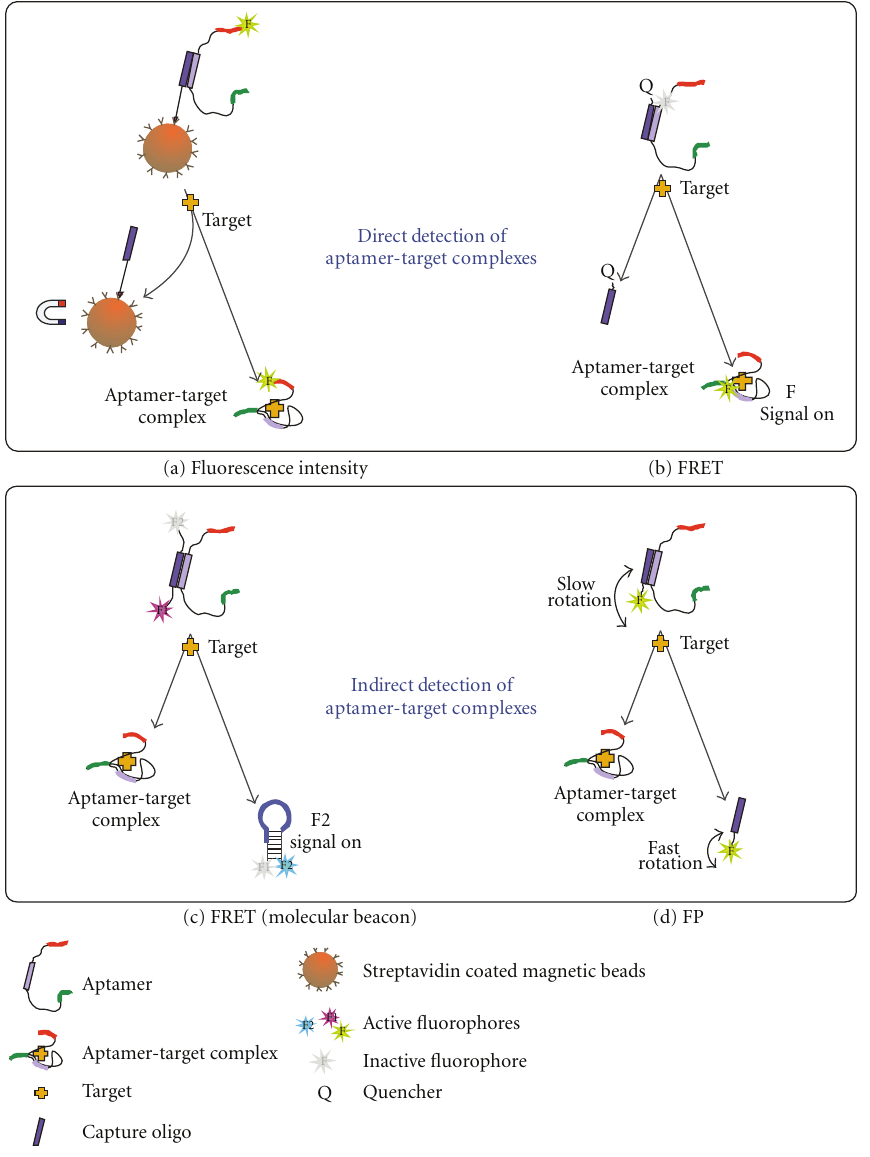
Figure 8: Potential assay strategies using aptamers selected by the Capture-SELEX principle. The switch from the hybridized to the dehybridized stage of the aptamers after target addition can be used to generate a recordable signal based on fluorometric methods like changes in fluorescence intensities, fluorescence resonance energy transfer (FRET), FRET with molecular beacon formation, or fluorescence polarization